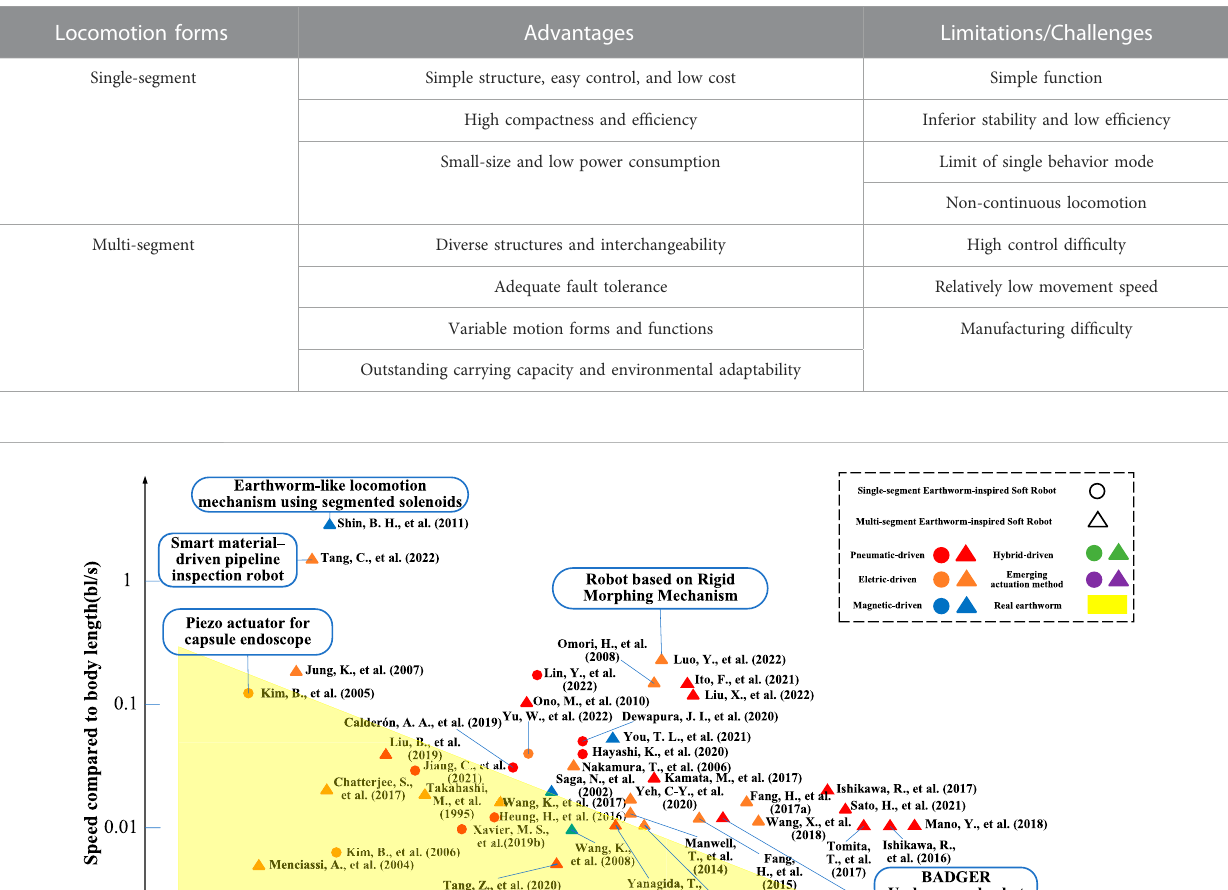
TABLE 2 Comparison between various locomotion forms used for earthworm-inspired soft robots.